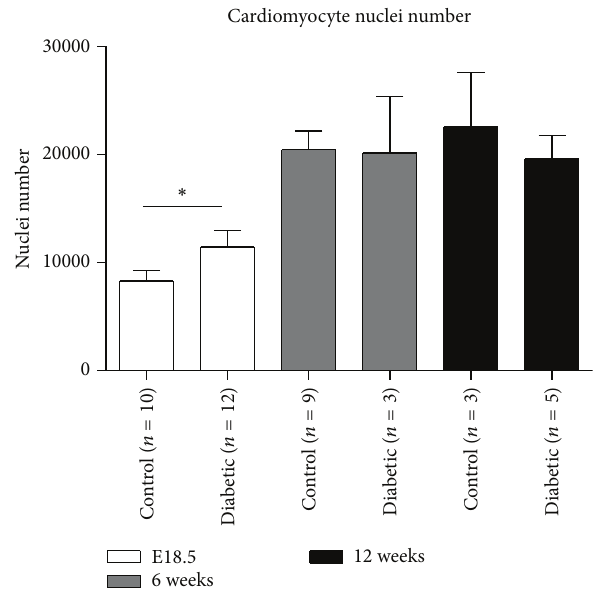
Figure 2: Comparison of cardiomyocytes nuclear size. Cardiac tissues derived from offspring of control and diabetic groups from E18.5 (white bars), 6 weeks (grey bars), and 12 weeks (bars) of age were stained with haematoxylin and eosin. Slides were digitally scanned and the nuclear size of the cardiomyocytes was calculated using a modified algorithm from Aperio. Mean nuclear area ( 𝜇 M) is presented. ∗ 𝑃 < 0.05 .